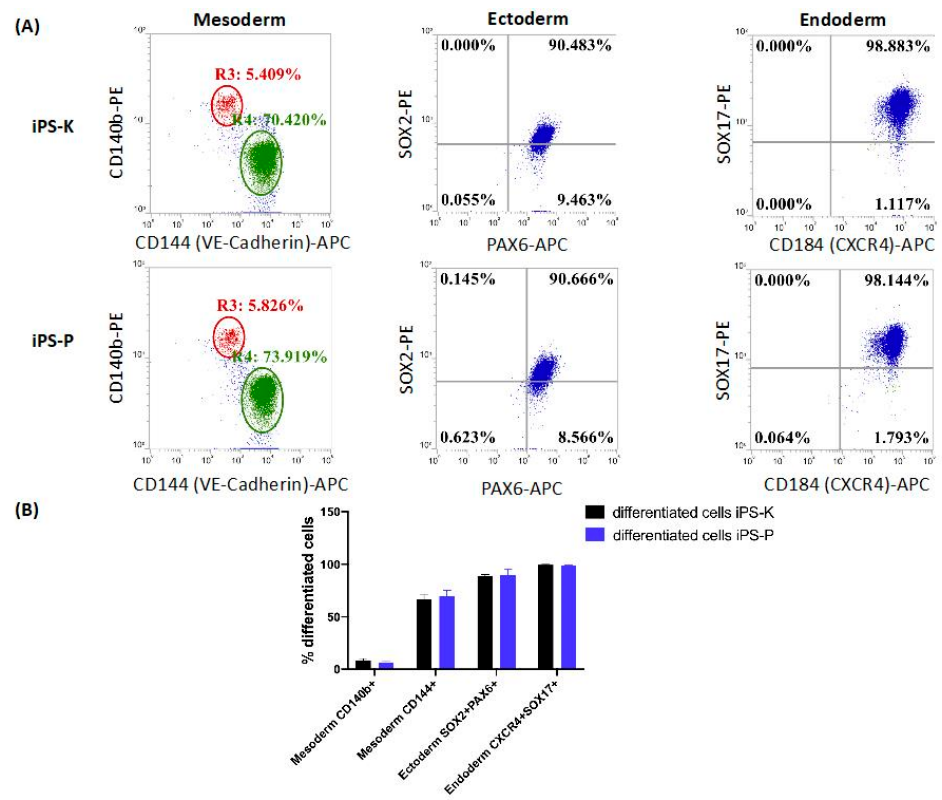
Figure 4. Differentiation iPS cells into three germ layers in vitro. ( A ) Representative plots of flow cytometry analysis of surface and intracellular marker expression of three differentiated iPS-K and iPS-P clones. The iPS cells were labelled with anti-CD144-PE, anti-140b-APC antibodies (mesodermal markers); anti-PAX6-APC, anti-SOX2-PE antibodies (ectodermal markers); anti-CD184-PE, anti-SOX17-APC antibodies (endodermal markers) and were analyzed by flow cytometry. ( B ) Graph presenting expression of various differentiation markers in three clones from iPS-K and three clones from iPS-P, n = 3. The results show mean +/ − SEM.